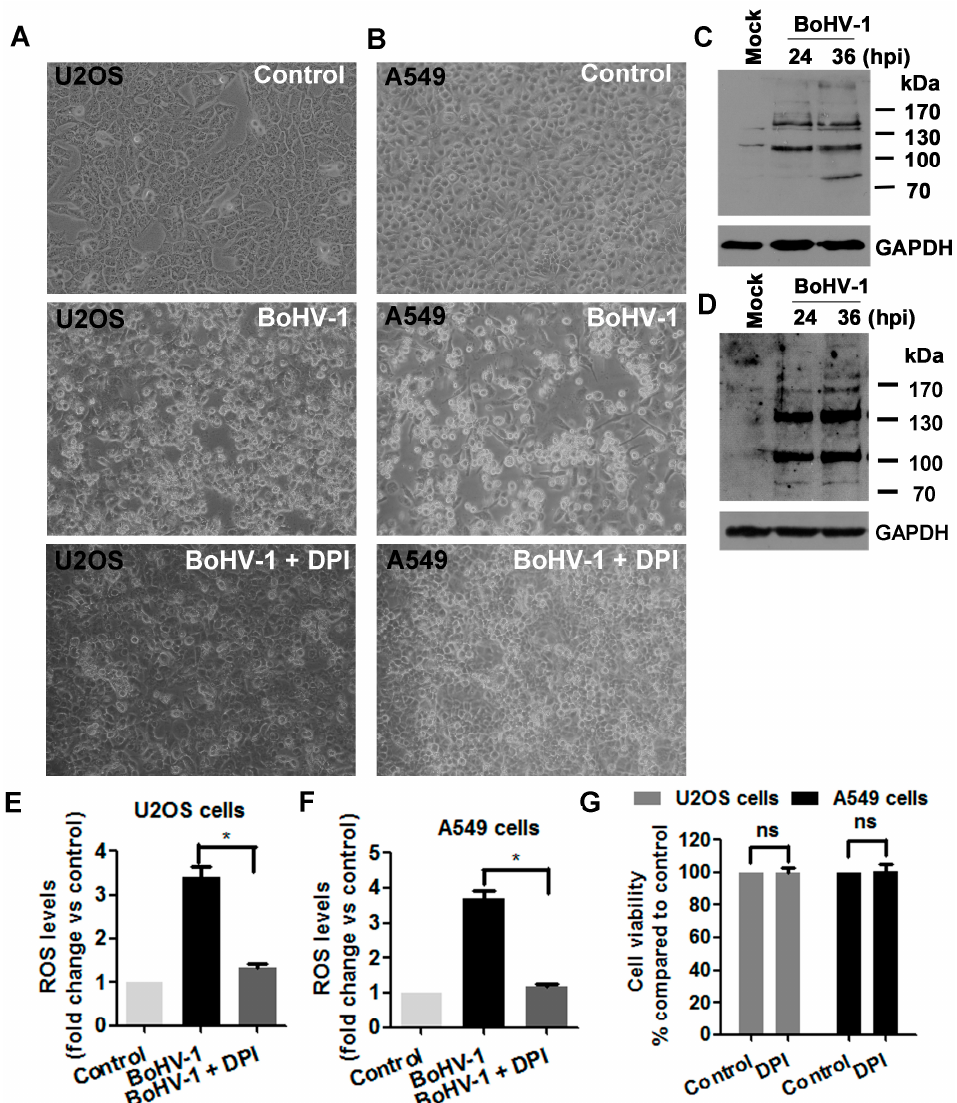
Figure 4. Virus infection enhanced ROS production during the infection of human tumor cells. ( A , B ) U2OS cells ( A ) and A549 cells ( B ) were infected by BoHV-1 (MOI = 0.1) for 48 h, with or without DPI (5 Μ m) treatment. The cell morphology was observed under light microscope. Images shown were representative of three independent experiments (Magnification ×200). ( C , D ) U2OS cells ( C ) and A549 cells ( D ) were infected with BoHV-1 (MOI = 0.1). At 24 h and 36 h after infection, the cells lysates were prepared and subjected to Western blotting analysis using goat anti-BoHV-1 serum (VMDR Inc.,